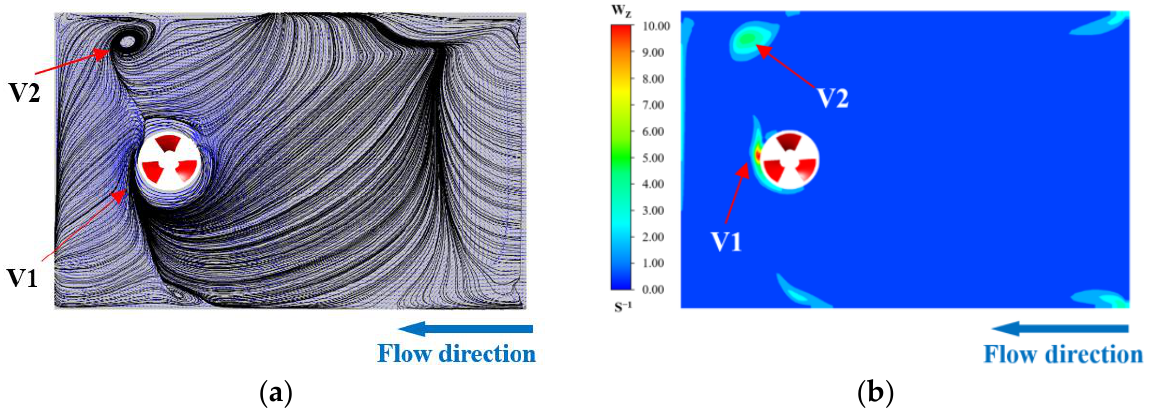
Figure 6. Roof-attached vortex (RAV) in the closed sump at the time T ( Q = 5.02 s −2 ).